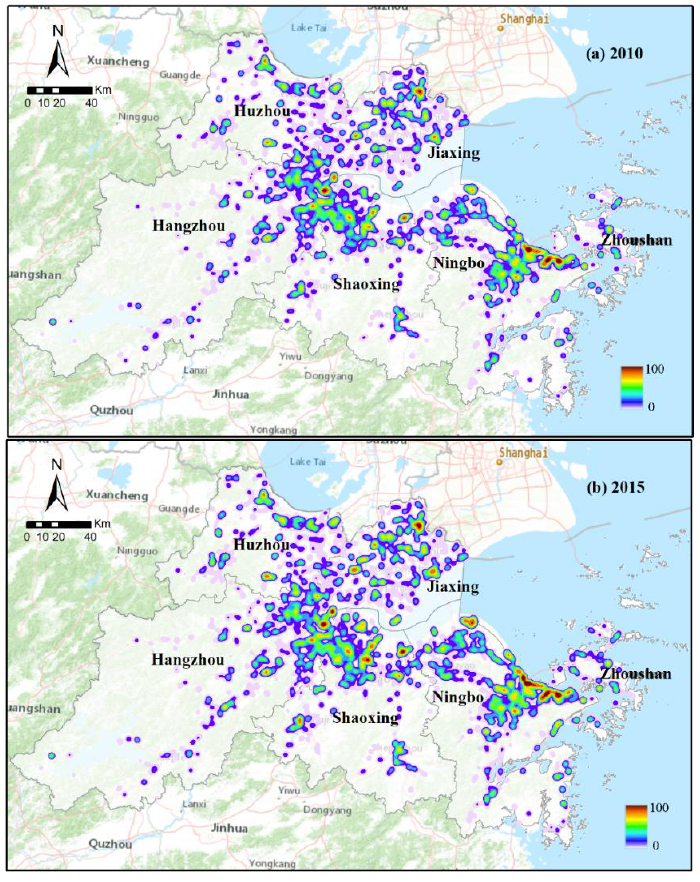
Figure 11. Spatial distribution of industrial cluster areas in 2010 ( a ) and 2015 ( b ).